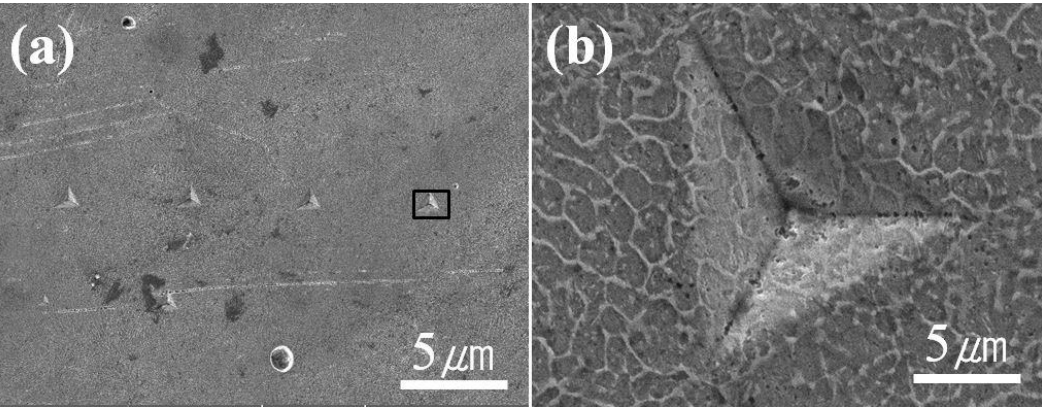
Figure 2. ( a ) An example of a scanning electron microscope (SEM) graph of indenter points of an SLM H13 at the 100 mm/s scanning speed and ( b ) a close-up view at the location indicated by the rectangle in ( a )